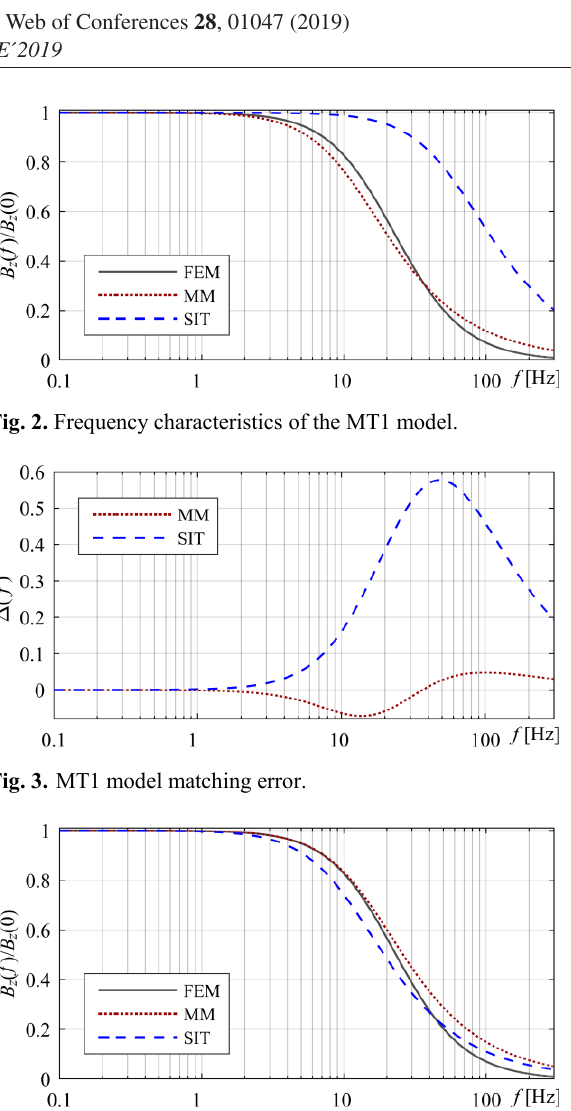
Fig. 4. Frequency characteristics of the MT2 model.